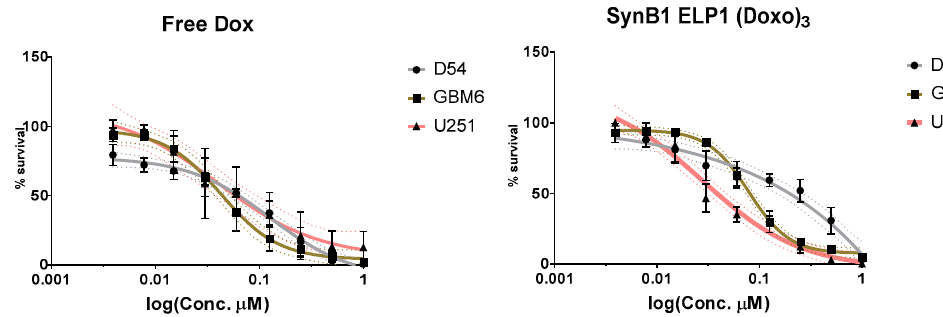
Figure 2. Cytotoxicity effects of free Doxorubicin and SynB1-ELP1-DOXO. D54, GBM6, and U251-MG cells were exposed to varying concentrations of SynB1-ELP1-DOXO, or free Dox for 72 h at 37 °C, and the number of viable cells was estimated with CellTiter-Glo ® assay. The data represent an average of at least three experiments (error bars represent S.E.M.). ( a ) Comparison of free Dox and SynB1-E1-DOXO cytotoxicity within cell lines. ( b ) Comparison of free Dox and SynB1-E1-DOXO cytotoxicity effect between cell lines.